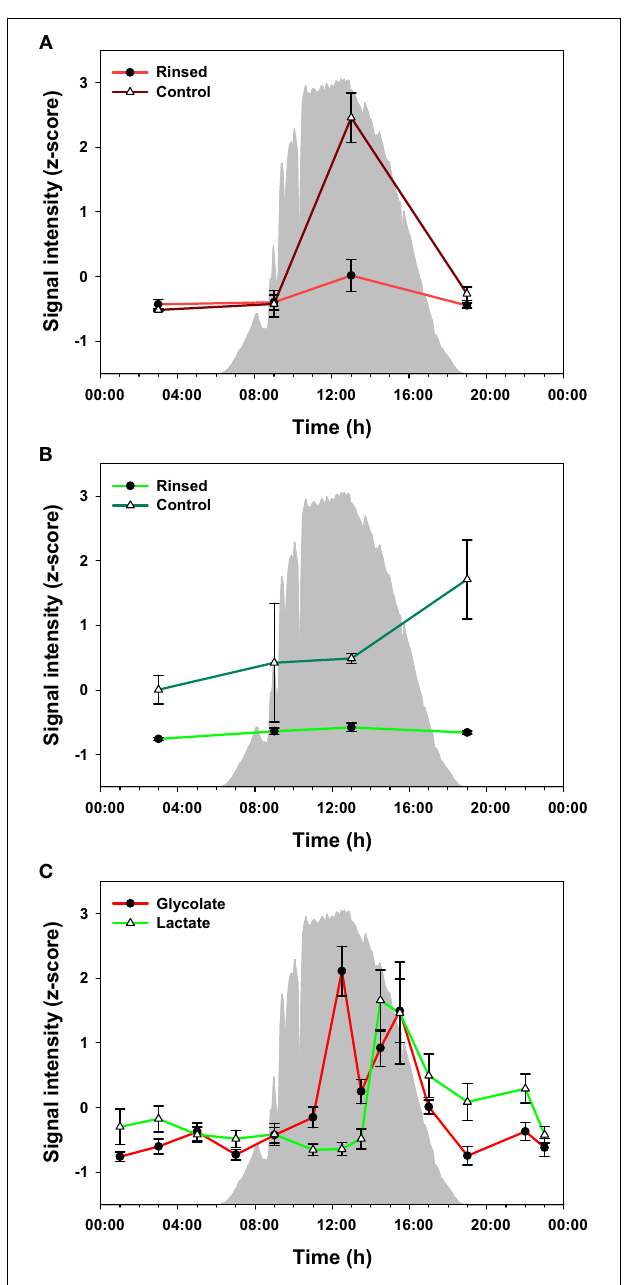
FIGURE 5 | Measured levels of glycolate (A) and lactate (B) from the rinsed and control (un-rinsed) mats. The difference between the two conditions is regarded as a portion biologically available by excretion and diffusion in the mats, which can be taken up by other heterotrophic bacteria in the communities. Glycolate and lactate profiles in the unrinsed mat over the full diel cycle (C) are shown as a reference. The glycolate and lactate abundances were z-score transformed (i.e., normalized), and the values plotted are mean ± standard error ( n = 3 ). Solar irradiance is shown in solid gray.